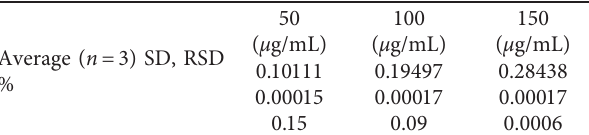
Table 5: Interday analysis of SRP (analyst 2).